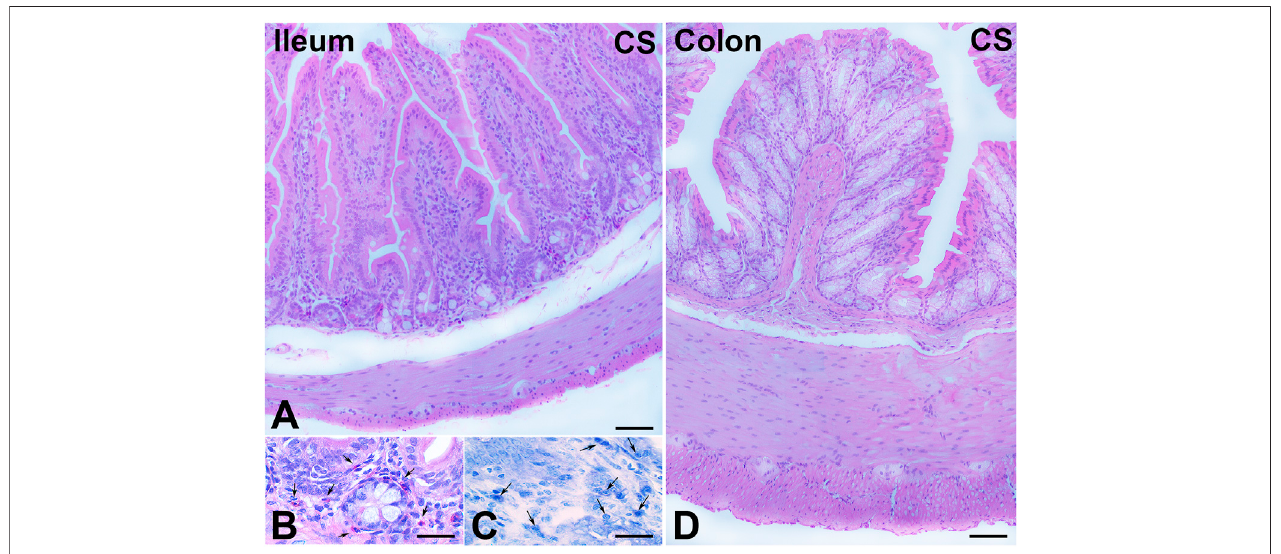
FIGURE 1 | Hematoxylin – eosin (H&E) and Toluidine blue (TB) staining and cell in fi ltrates. (A – C) Ileum. (A) Full-thickness section showing the integrity of the enteric wall. (B) Numerous eosinophil granulocytes ( arrows ) in the mucosa. (C) TB staining pointing out several plasma cells ( arrows ) in the mucosa. (D) Colon. Full-thickness section showing the integrity of the enteric wall. Bars , 100 μ m (A,D) and 25 μ m (B,C)